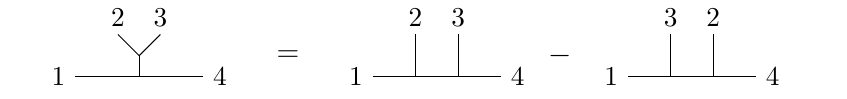
Figure 1 . The tree-level BCJ master numerators N diagrams with legs 1 and n at opposite endpoints.